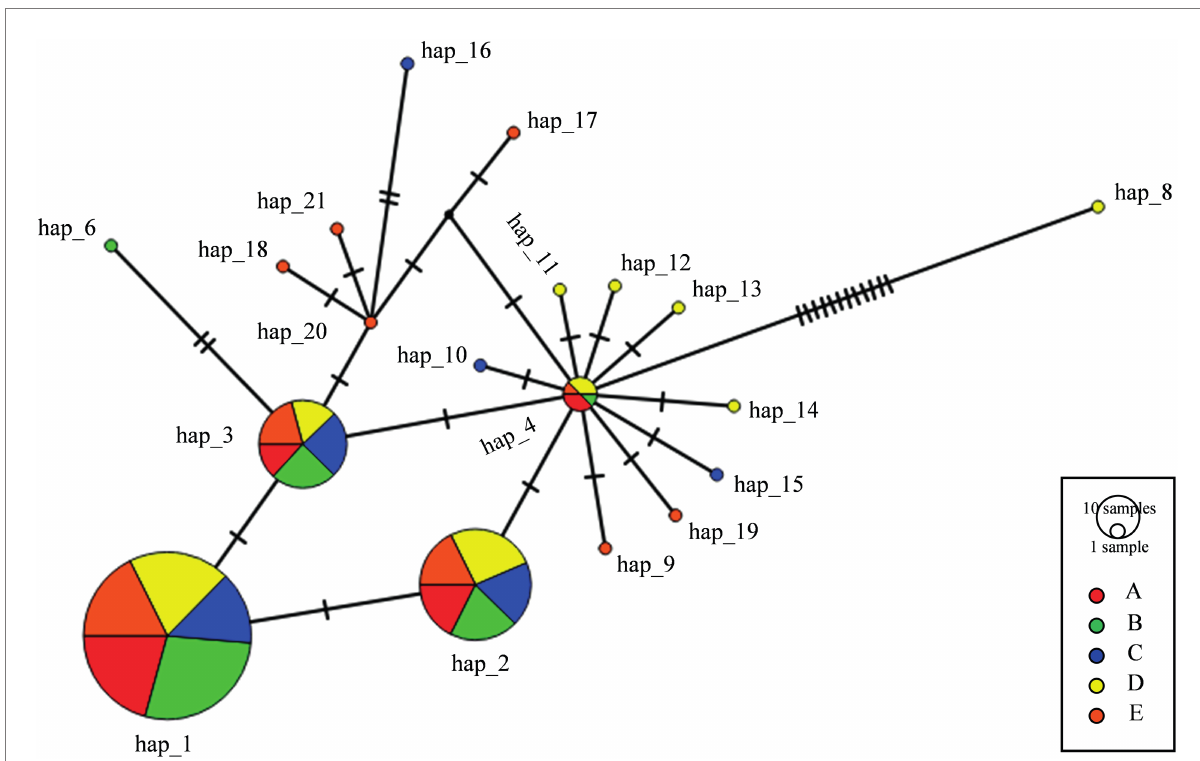
FIGURE 2 Haplotype network of Pi02860 gene. Nucleotide haplotypes are named with Hap followed by a number. Size of the circles indicates haplotype frequencies in the population. Colors correspond to the respective populations. Each tick mark represents a step of nucleotide substitution. Hap_5 and Hap_7 have a mutation in start codon and were removed from haplotype network